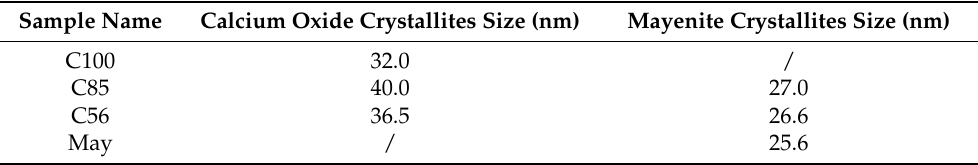
Table 3. CaO and mayenite crystallites size in various